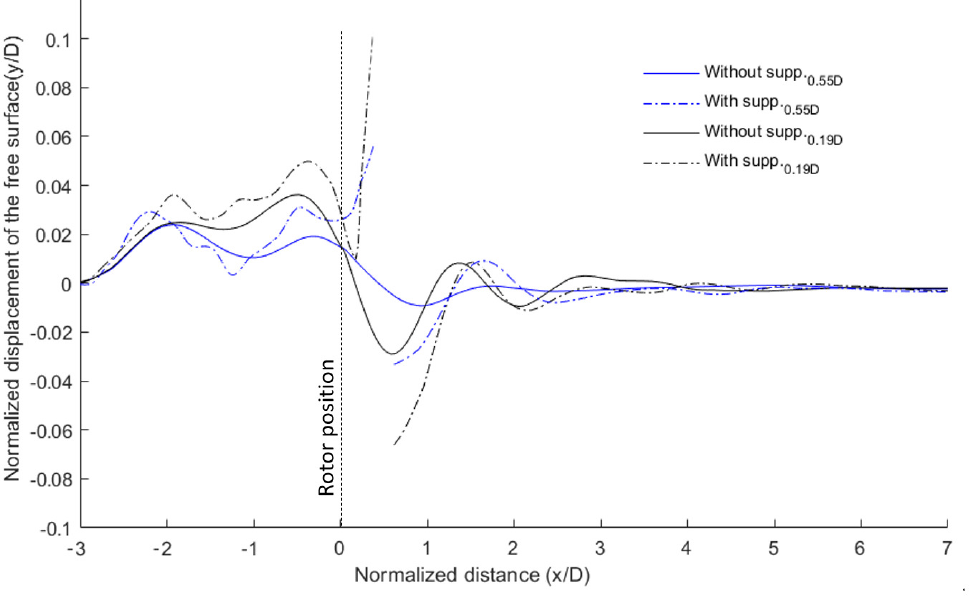
Figure 9. Vertical displacement of the free surface at the channel mid plane. Results for λ = 6 and two